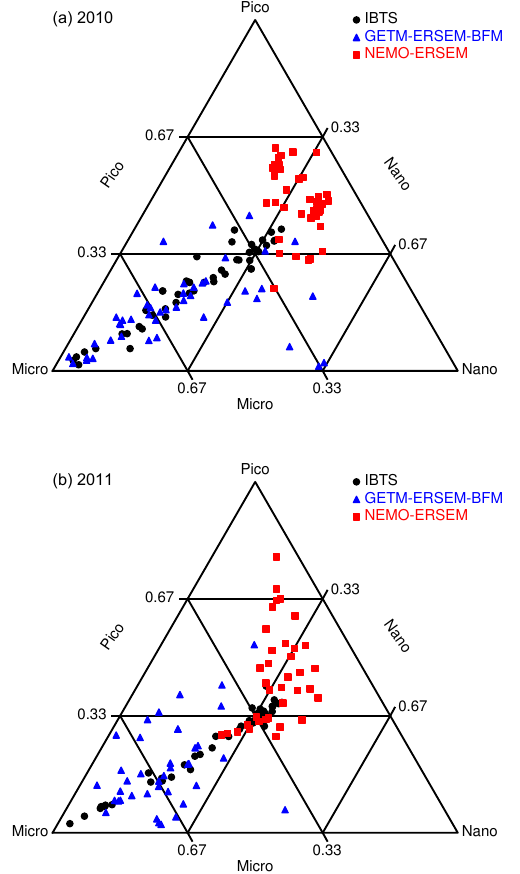
Figure 13. Ternary plots of phytoplankton community structure, showing the phytoplankton size class distribution at IBTS observa- tion locations in (a) 2010 and (b) 2011, from the IBTS observations, GETM-ERSEM-BFM, and NEMO-ERSEM.